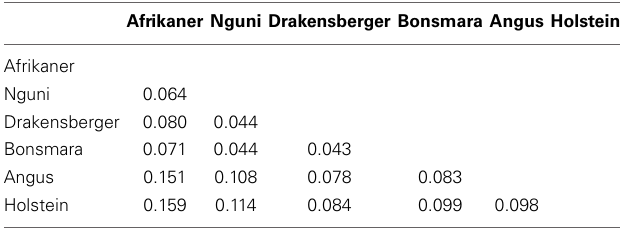
Table 3 | Wright fixation index ( F ST ) pair-wise among six cattle breeds in South African.